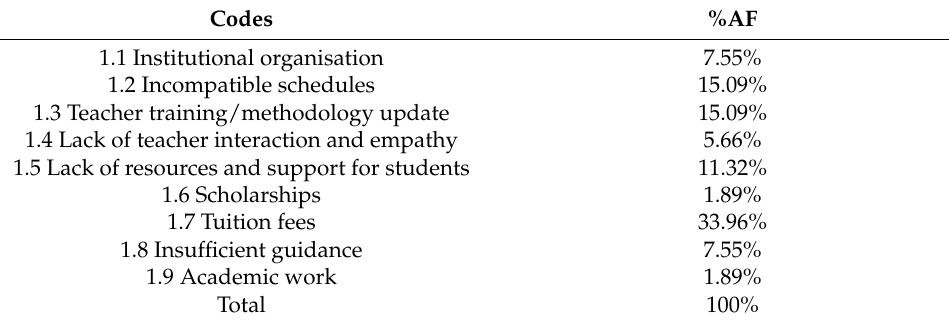
Table 1. Category 1 codes. Institutional